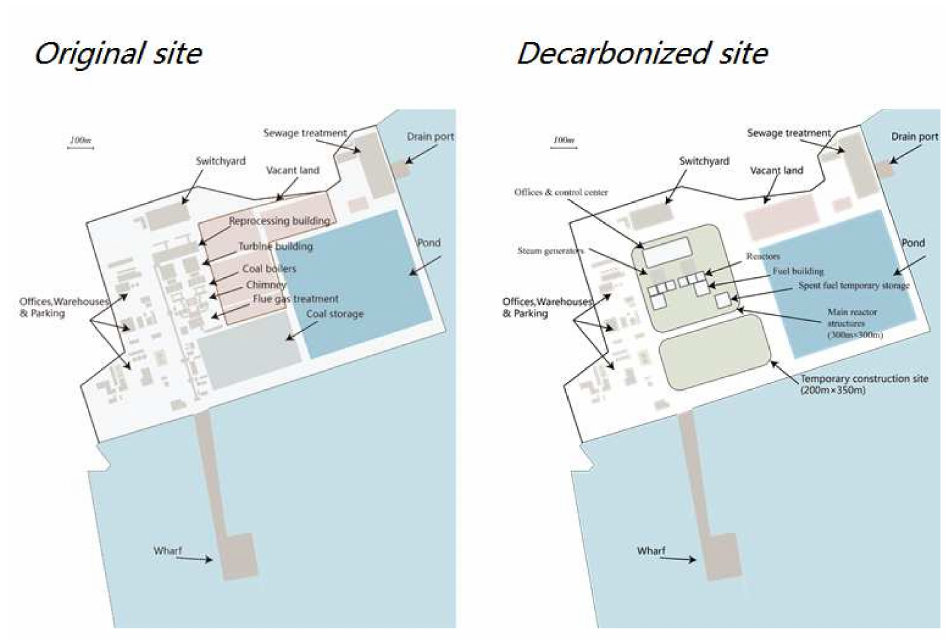
Figure A8. Retrofit decarbonization of Yangliuqing with nuclear reactors.